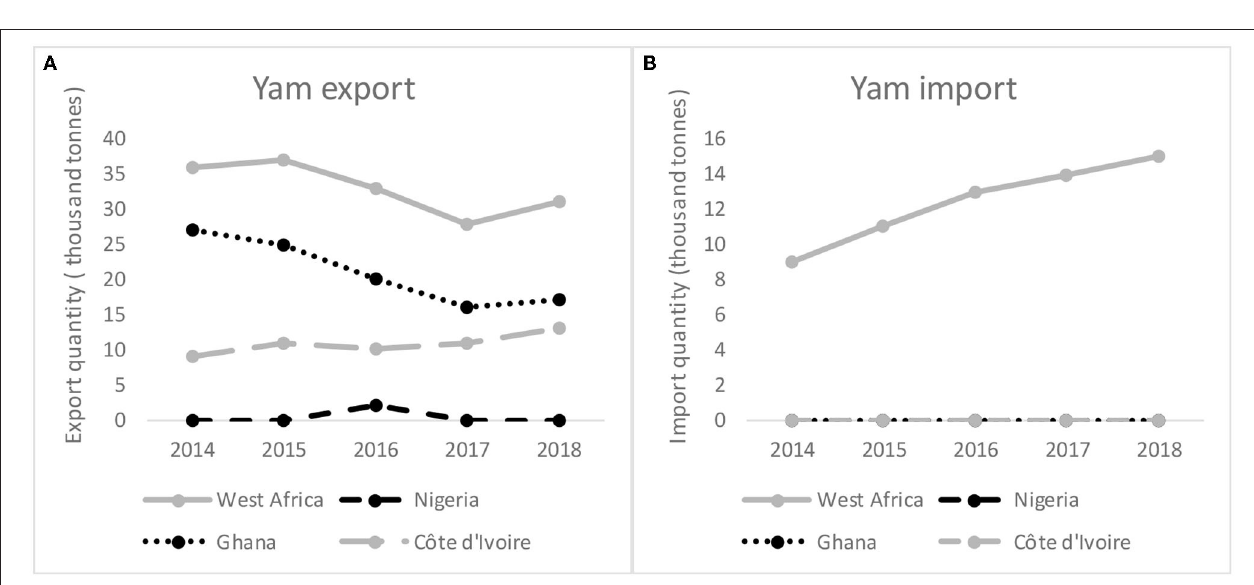
FIGURE 4 | Yam trade (A) export and (B) import in three leading yam-producing countries (Nigeria, Ghana, and Côte d’Ivoire) of West Africa. The graphs were drawn with data from FAOSTAT